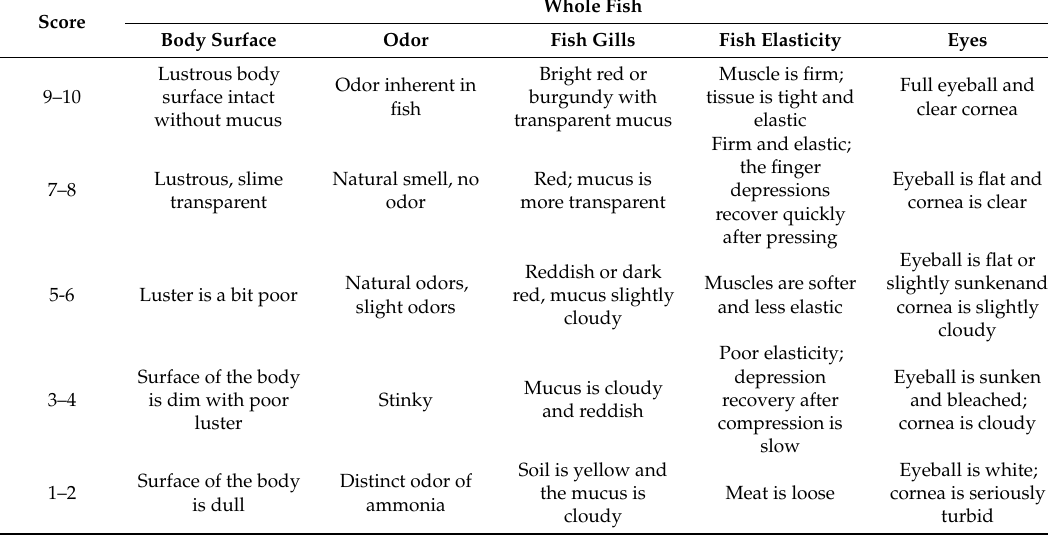
Table 1. Sensory Evaluation Standard of Spanish Mackerel at 0 ◦ C Cold-Chain Storage